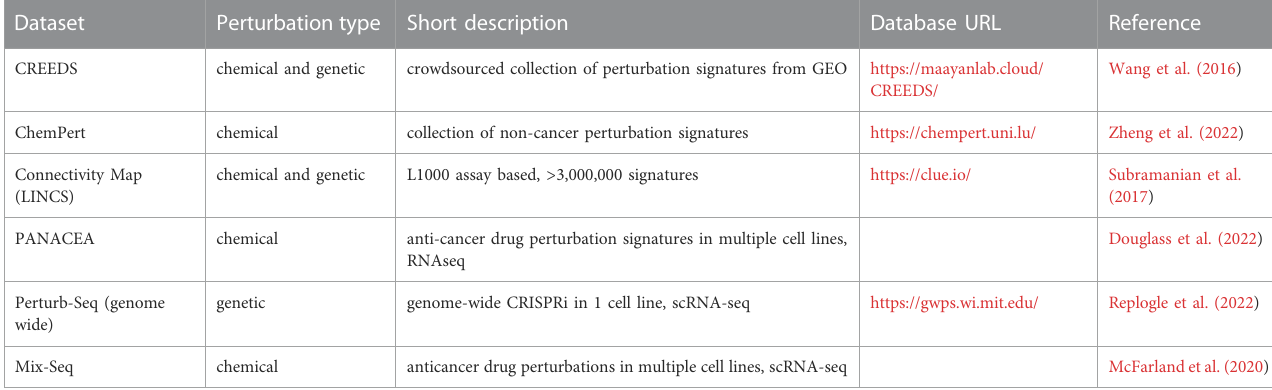
TABLE 1 Public datasets and databases for perturbation gene expression pro fi les.